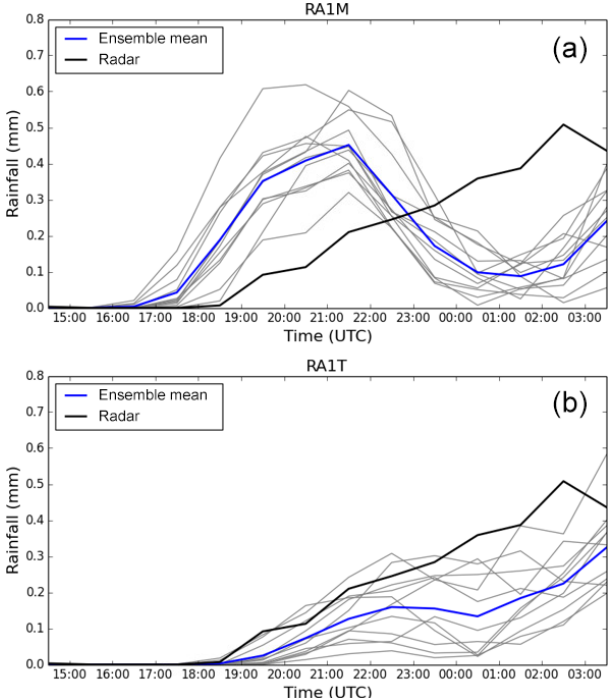
Figure 22. Domain-averaged precipitation from the RAL1-M en- semble (a) and RAL1-T ensemble (b) for 16–17 May 2017. Aver- aged over Texas and